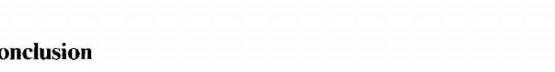
that the fluorescence has been quenched by increas ing chloride ion concentration at low pH or that protonation of the excited state is occurring: further studies are in progress.